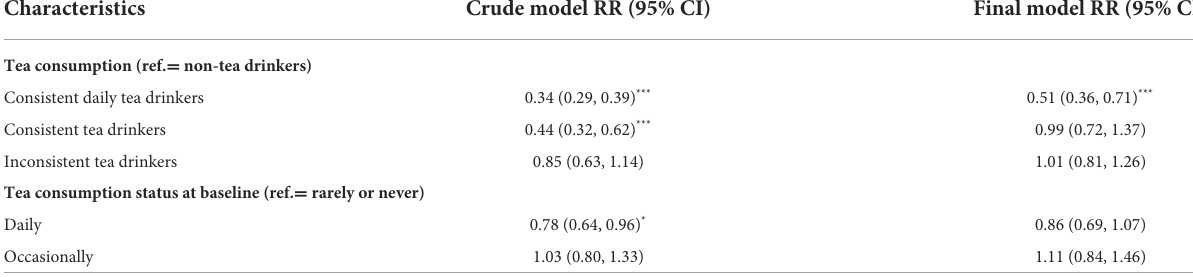
TABLE 2 Associations between tea consumption and frailty among older Chinese people. Characteristics